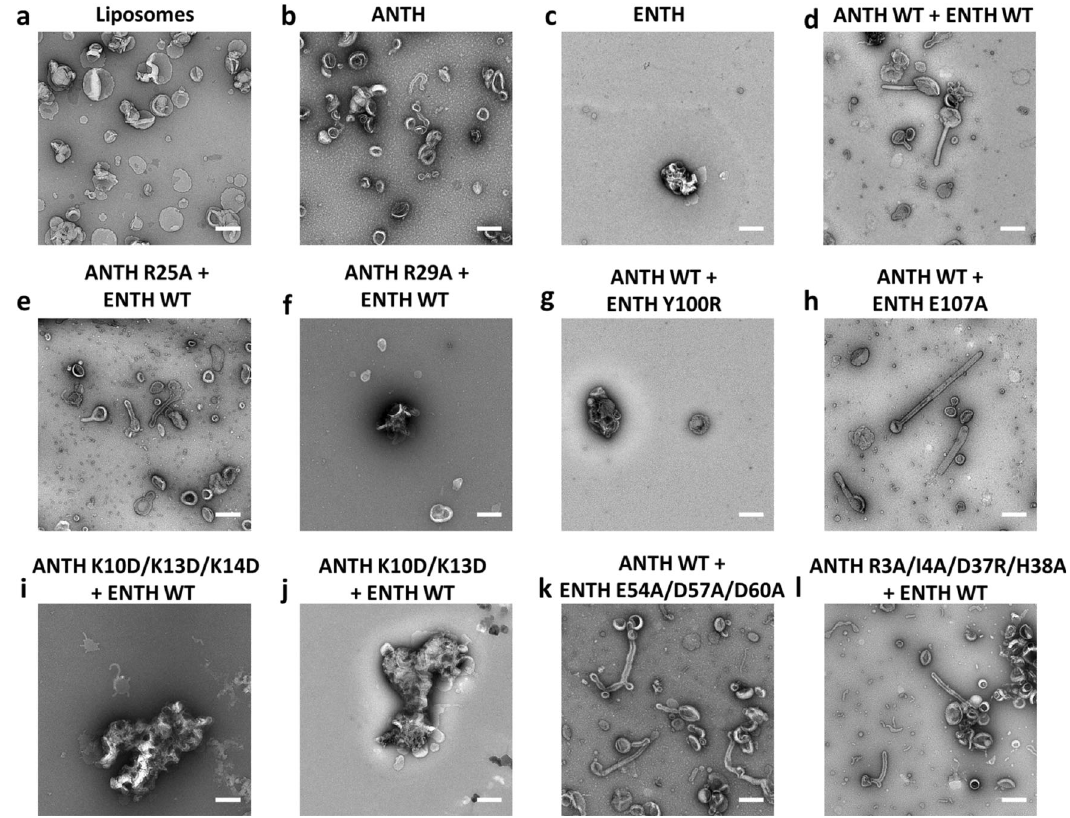
Fig. 7 Effect of AENTH tetramer mutants on LUVs by the negative stain. a LUVs observed by negative staining. b ANTH does not deform LUVs notably. c . ENTH causes LUVs to become aggregated and to adopt irregular shapes. d ANTH together with ENTH reshapes LUVs into tubular structures as previously reported 18 . e – l ANTH and ENTH mutants show different effects on LUVs. ANTH R25A ( e ), ENTH E54A/D57A/D60A ( k ) and ANTH R3A/I4A/ D37A/H38A ( l ) mutants (mixed with its wild type partner domain) display an AENTH wt phenotype reshaping LUVs into tubular structures ANTH R29A ( f ) and ENTH Y100R ( g ) ANTH K10D/K13D/K14D ( i ) and ANTH K10D/K13D ( j ) mutants (mixed with its wild type partner domain) display an ENTH wt phenotype being unable to tubulate LUVs. Each experiment was repeated independently 3 times with similar results. All scale bars are 200